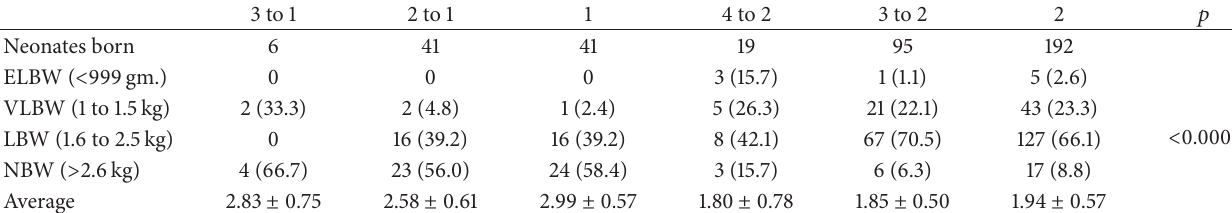
Table 4: Birth weight of babies born according to gestation and